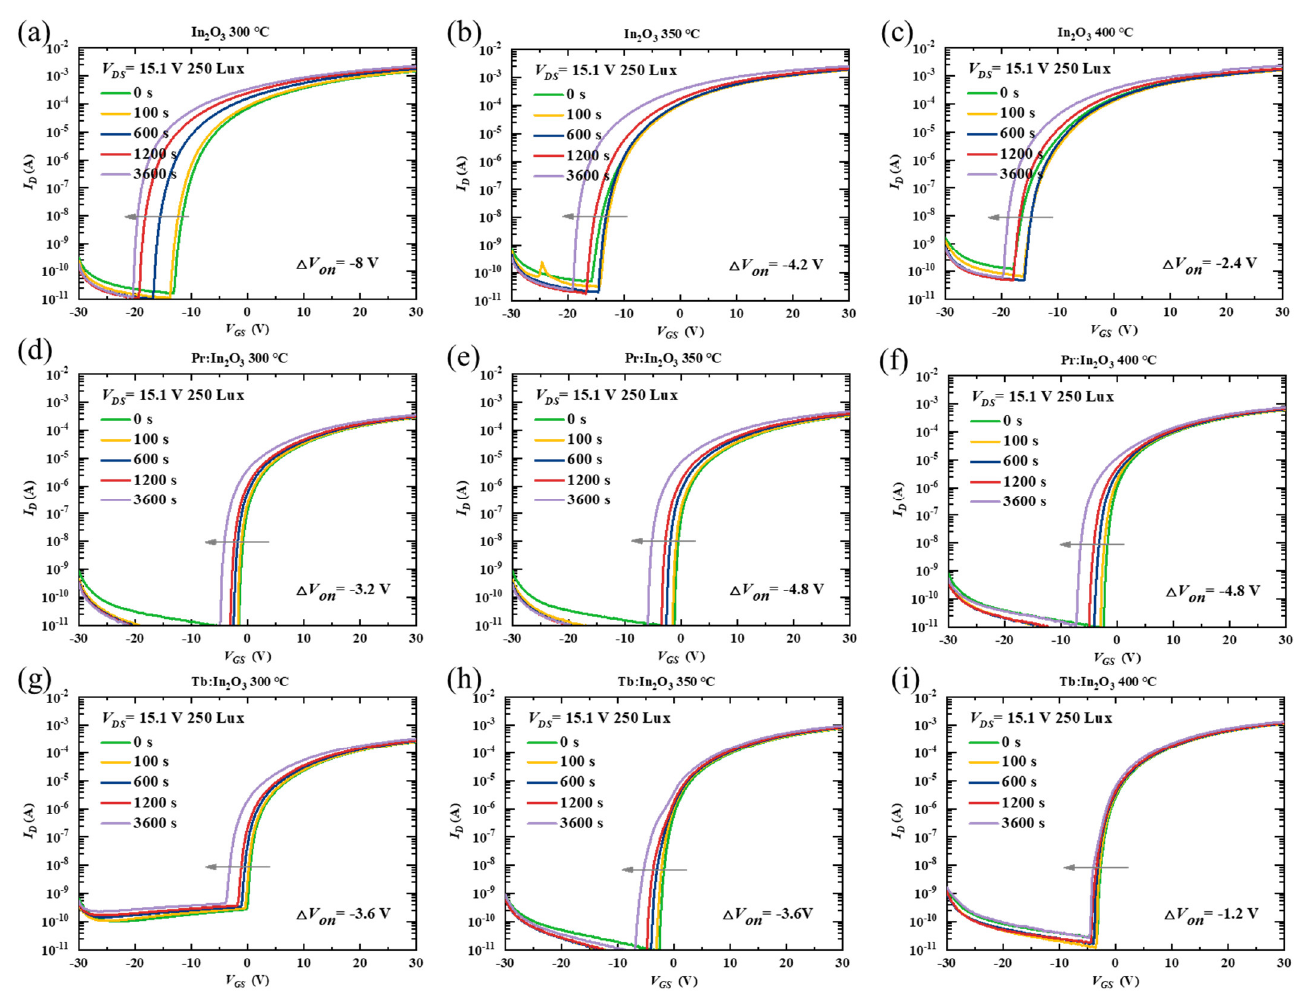
Figure 3. Variations of time-dependent transfer curves under NBIS (a negative gate bias stress of −20 V combined with white LED light illumination of 250 Lux) for the TFTs with − 20 V combined with white LED light illumination of 250 Lux) for the TFTs with channels of In channels of In 2 O 3 (annealed at ( a ) 300 °C, ( b ) 350 °C, ( c ) 400 °C), Pr:In 2 O 3 (annealed at ( d ) (annealed at ( a ) 300 ◦ C, ( b ) 350 ◦ C, ( c ) 400 ◦ C), Pr:In 2 O 3 (annealed at ( d ) 300 ◦ C, ( e ) 350 ◦ C, ( f ) 400 ◦ C), 300 °C, ( e ) 350 °C, ( f ) 400 °C), and Tb:In 2 O 3 (annealed at ( g ) 300 °C, ( h ) 350 °C, ( i ) 400 °C). and Tb:In 2 O 3 (annealed at ( g ) 300 ◦ C, ( h ) 350 ◦ C, ( i ) 400 ◦